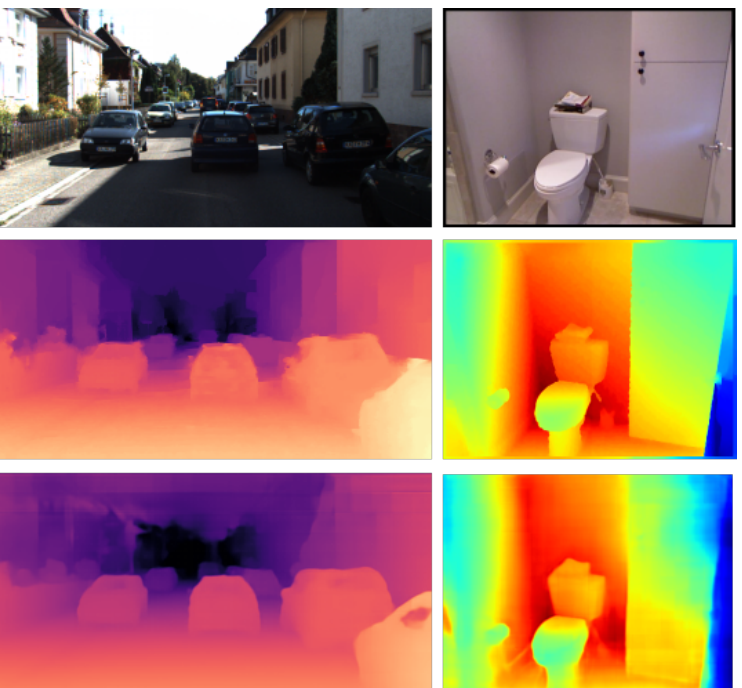
Figure 1. Depth estimation examples. From top to bottom: input color images, ground truths and outputs inferred by the proposed network. Note that the left example is from the KITTI dataset [23], and the right one belongs to the NYU Depth V2 dataset